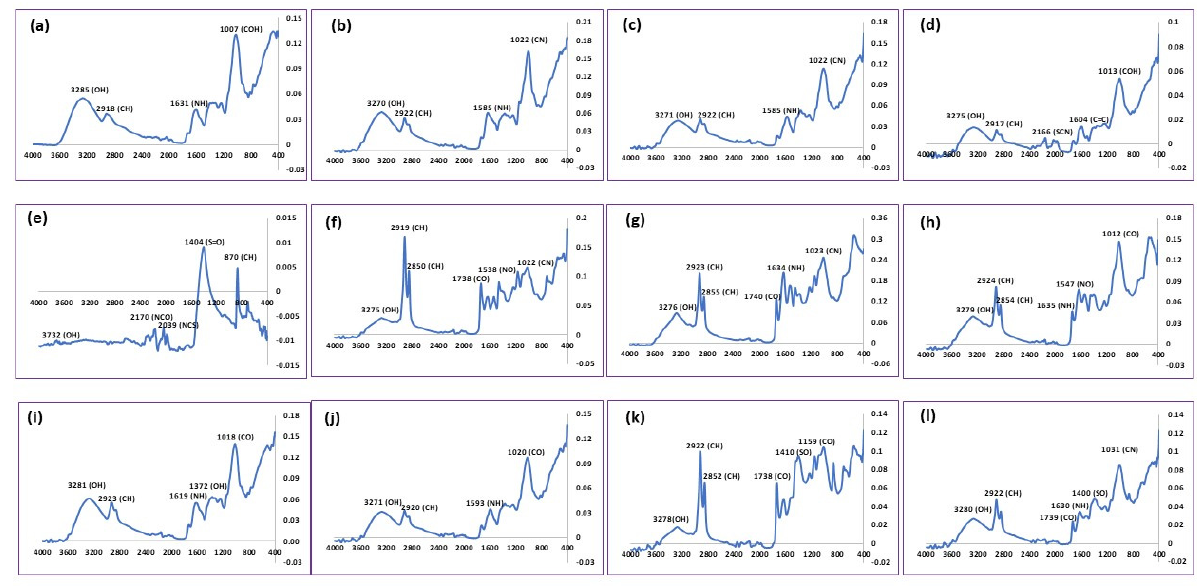
Figure 4. Thermogravimetric analysis of different food waste (( a ). brinjal waste, ( b ). potato peels, ( c ). banana peels, ( d ). orange peel, ( e ). eggshell, ( f ). cow bone, ( g ). chicken bone, ( h ). fish bone, ( i ). combined vegetable, ( j ). combined fruits, ( k ). combined animal, and ( l ). all combined).